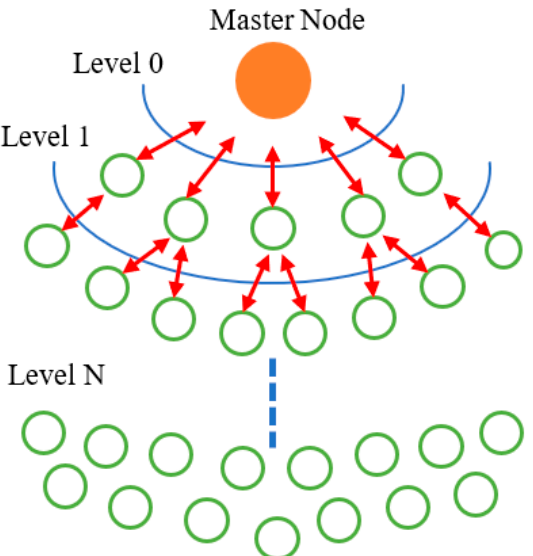
Figure 5. Hierarchical structure.